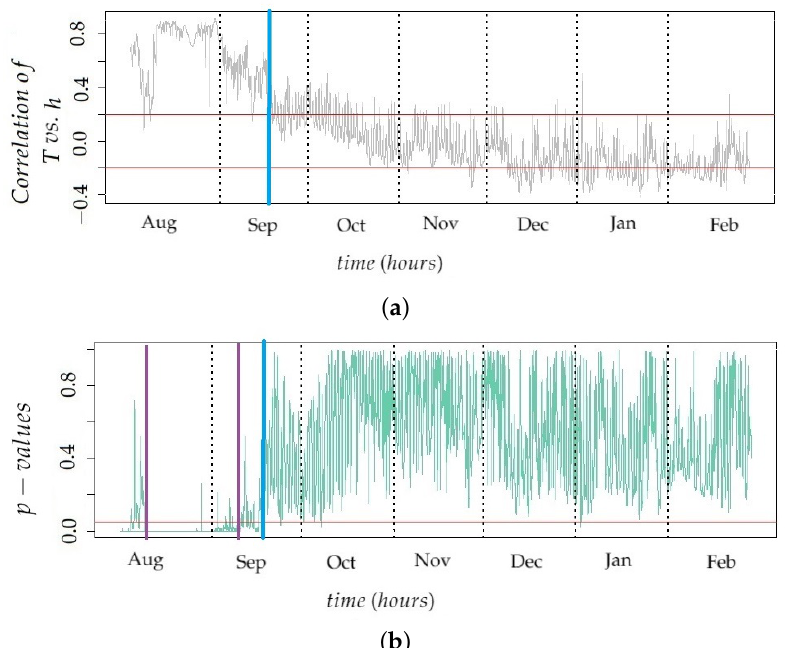
Figure 9. ( a ) Evolution of the correlation coefficient ( r ) between sensor height and temperature, over time (hour). Horizontal red lines correspond to values of 0.20 < r < 0.20. Dashed vertical lines − account for the different months. ( b ) p -value from the correlation test over time (hour). The red horizontal line corresponds to a p -value = 0.05; for lower values, the correlation was regarded as statistically significant. Purple vertical lines correspond to August 10th at 8:00 AM and September 9th at 11:00 PM. The blue line indicates September 17th at 9:00